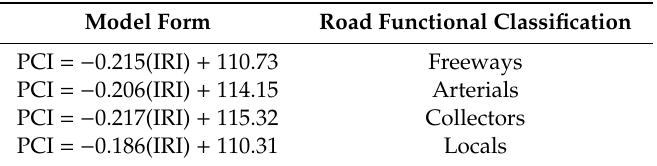
Table 1. Prediction of PCI for various road functional classifications.